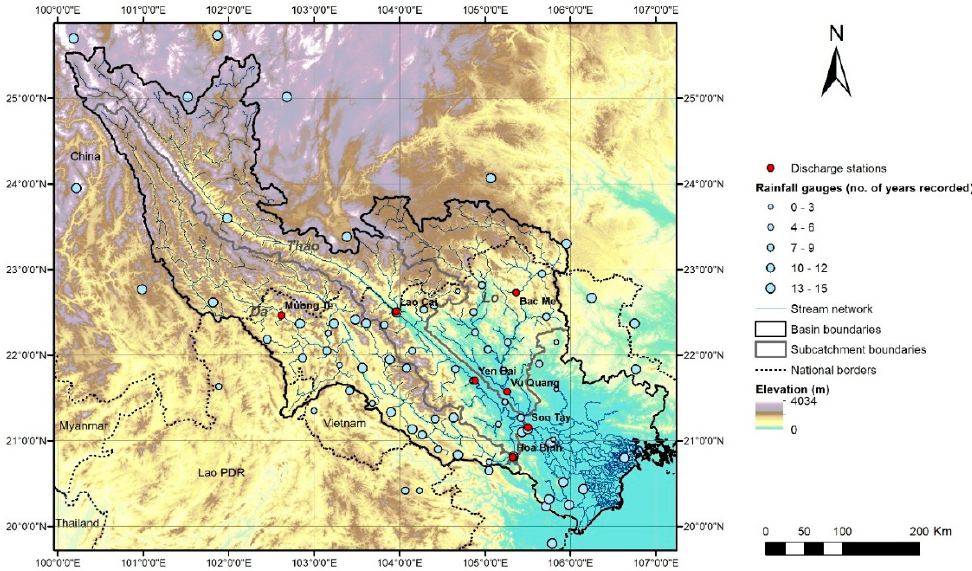
Figure 1. The Red River Basin. Elevation was obtained from the Shuttle Radiometer Topography Mission (SRTM) data, and the main river network and catchment boundaries were derived from the SRTM elevation map. The stream network downstream of Son Tay mainly consists of irrigation canals and was provided by the Institute of Water Resource Planning (IWRP) in Vietnam.